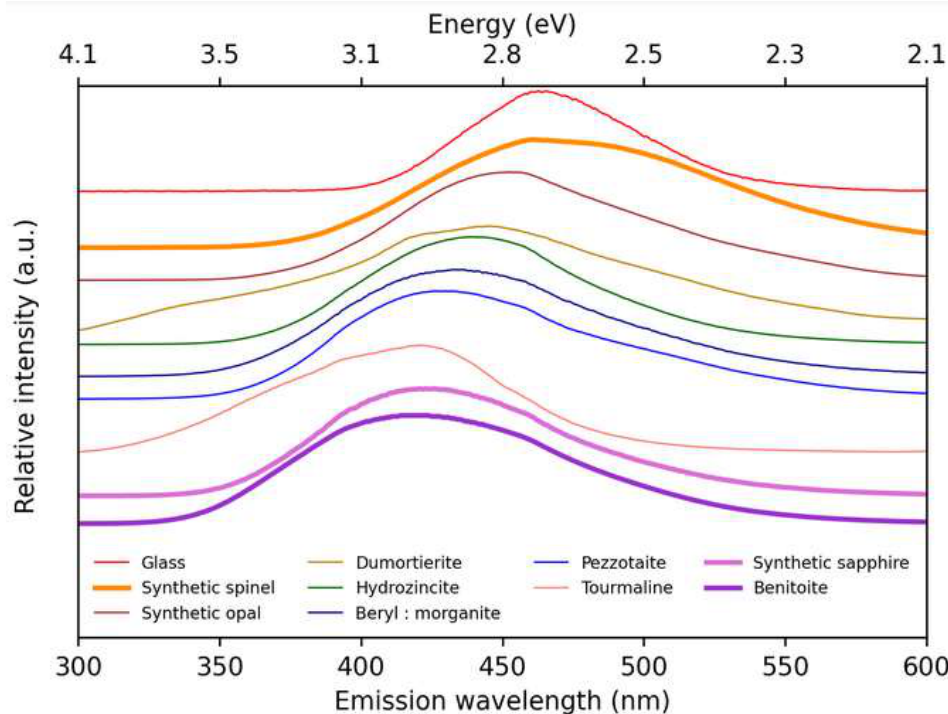
Figure 2. Emission spectra of our ten samples under λ ex = 254 nm at room temperature. Apparent maxima of the broad emission band are located in the 414 to 463 nm range. Thicker lines mark reference materials. Spectra are shifted vertically for clarity.